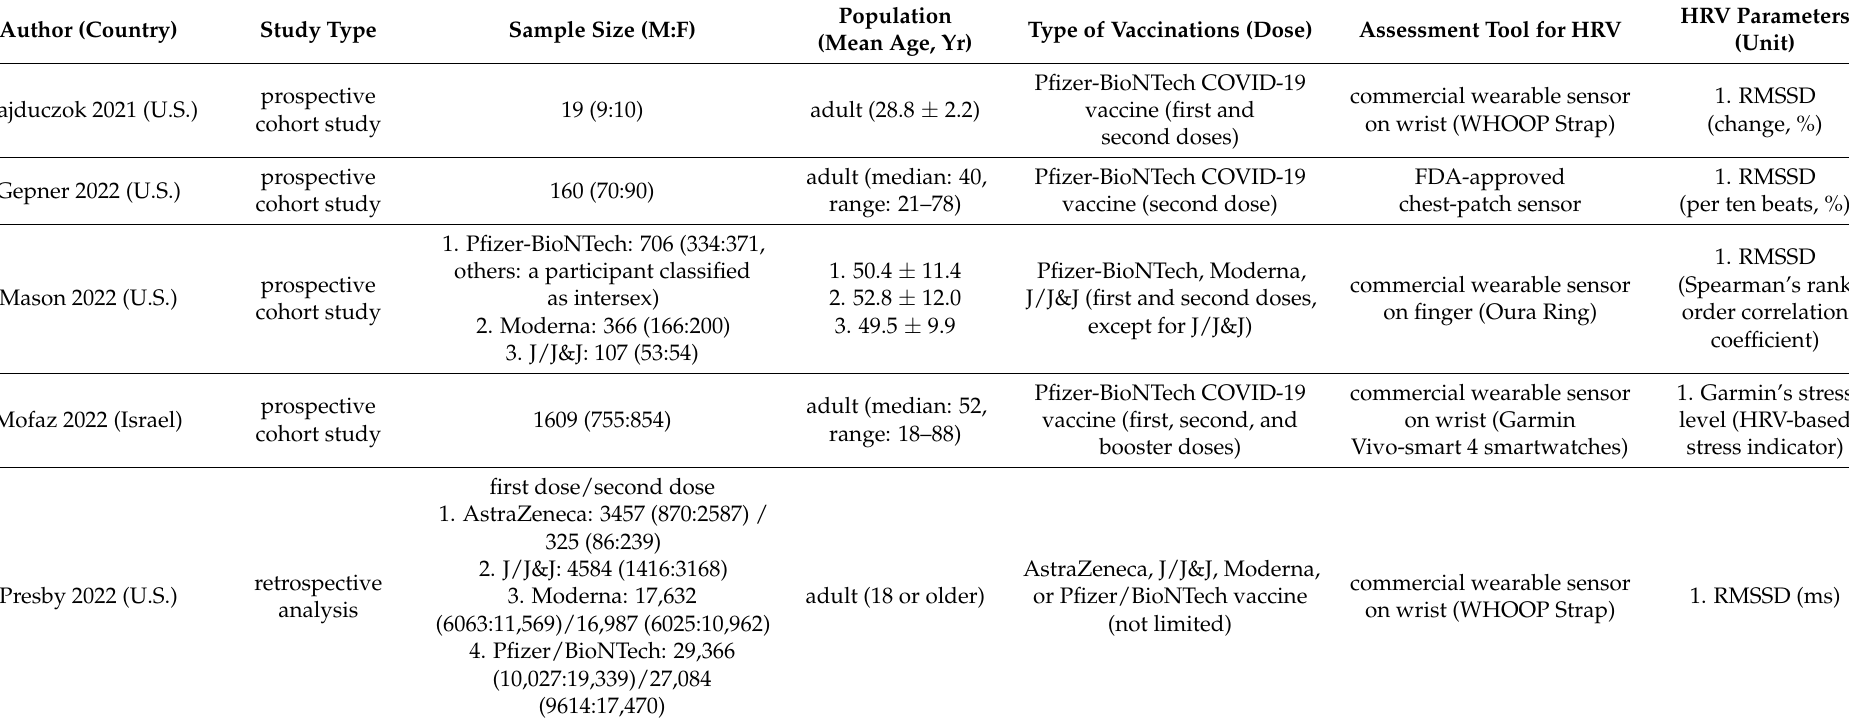
Table 1. Characteristics of included